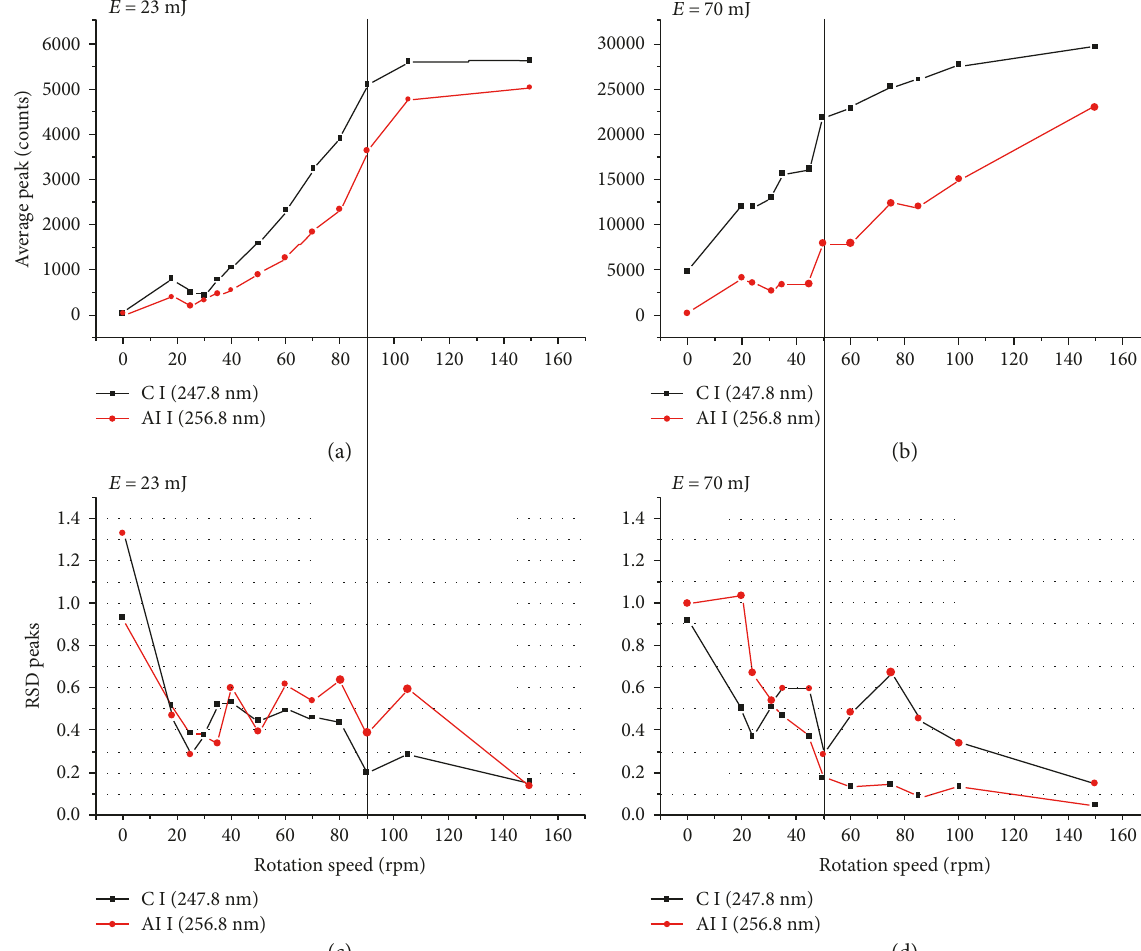
Figure 3: Average peak intensity of C I and Al I lines from the diesel droplet, measured over 10 pulses, as a function of the rotation speed for laser energies of 23mJ (a) and 70 mJ (b); the corresponding RSD is shown in (c) and (d), respectively. 2.0